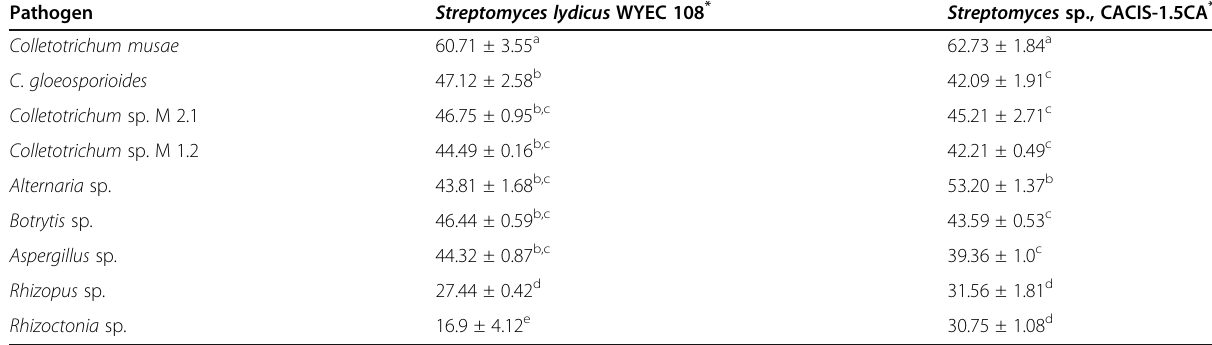
Table 2 Antagonism activity of Streptomyces sp. strain CACIS-1.5CA against fungal phytopathogens